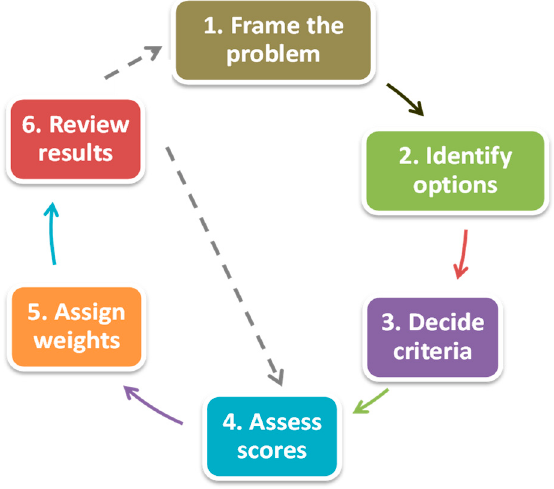
Figure 1. Steps of the multi-criteria mapping. Source: Adapted from Stirling [35] and Holdsworth [37].